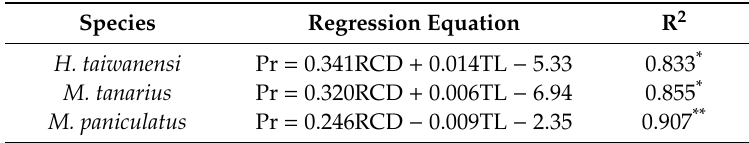
Table 7. Relationships among pullout resistance, root collar diameter and taproot length for the three species studied. Species